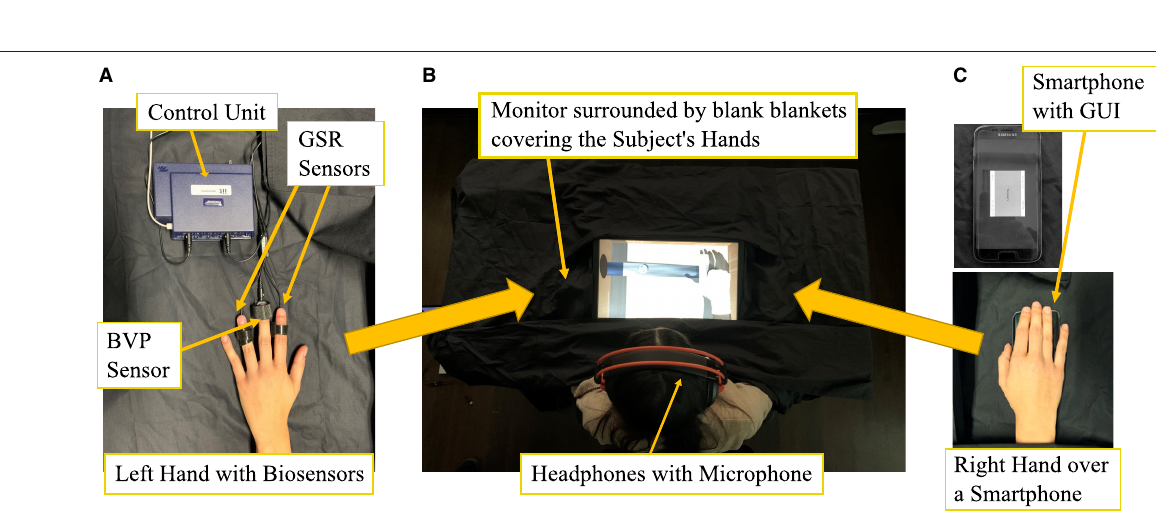
FIGURE 2 | Experimental setup. (A) Physiological recording equipment. (B) Display and headset. (C) Vibratory feedback device.